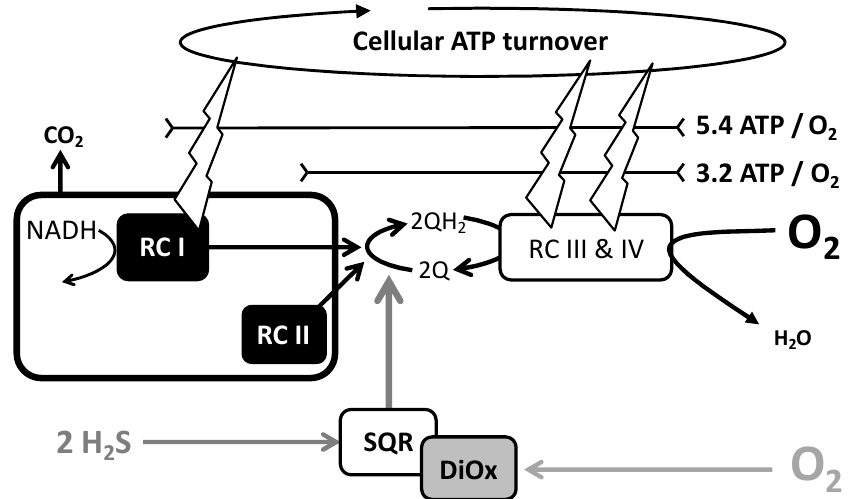
Figure 5. Cellular ATP turnover model. SQR and other redox enzymes, such as respiratory complexes I (RC I) and II (RC II), reduce the common redox intermediate quinone (Q/QH 2 ) whose reoxidation by respiratory complexes III and IV yields the reduction of oxygen (O 2 ) in water. RCI, III, and IV energize the mitochondrial membrane (symbolized as sparks), which ensures ADP phosphorylation into ATP by complex V (not shown) and therefore feed the cellular ATP turnover. RC I and RC II are linked to carbon oxidation schematized as a black box releasing CO 2 . SQR activity is associated with further oxygen consumption caused by dioxygenase (DiOx); here, thiosulfate is considered the final product (2 H 2 S and 2O 2 ). ATP regeneration depends on proton pumping by complexes I, III, and IV; it results that the ratio ATP/O 2 has different values according to the electron donor NADH (complex I) or FADH2/FMNH2 (complex II or SQR). A mixed contribution of carbon and sulfide oxidation will be considered with regard to the contribution to cellular ATP turnover, taking into account the constraint that sulfide oxidation is an absolute priority.